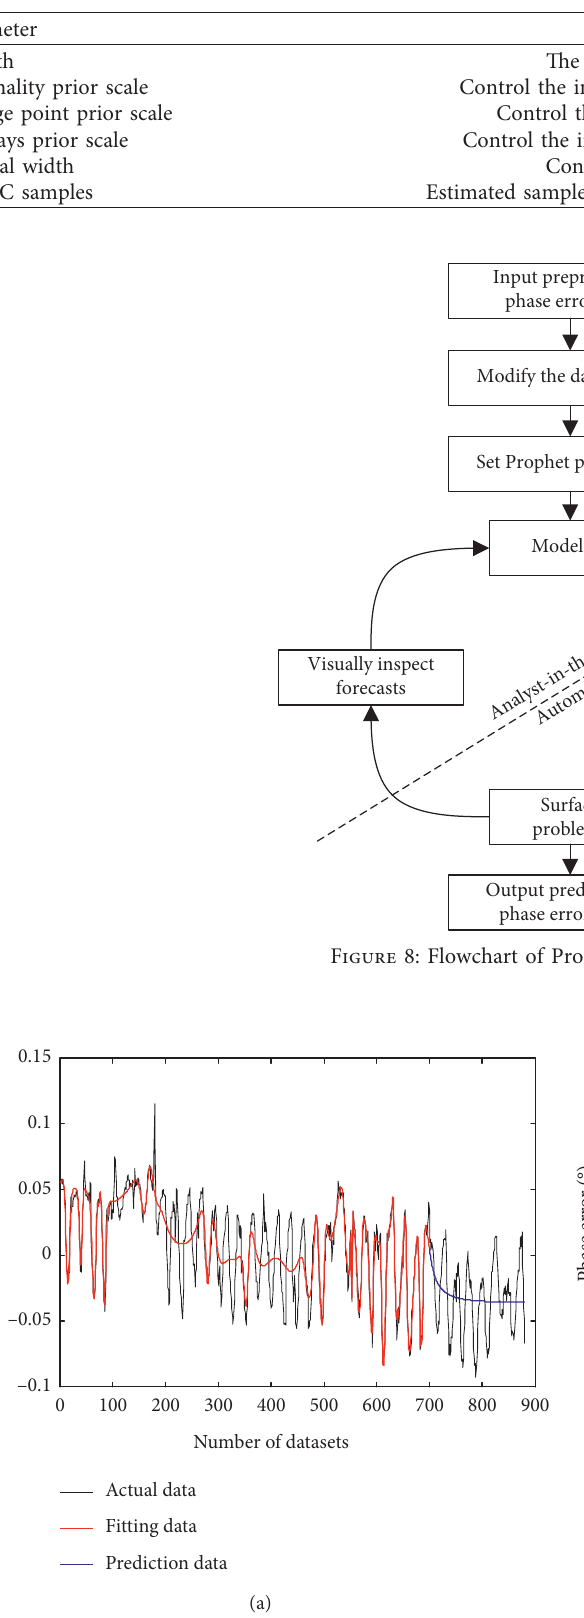
Table 2: Parameter settings of the Prophet model.